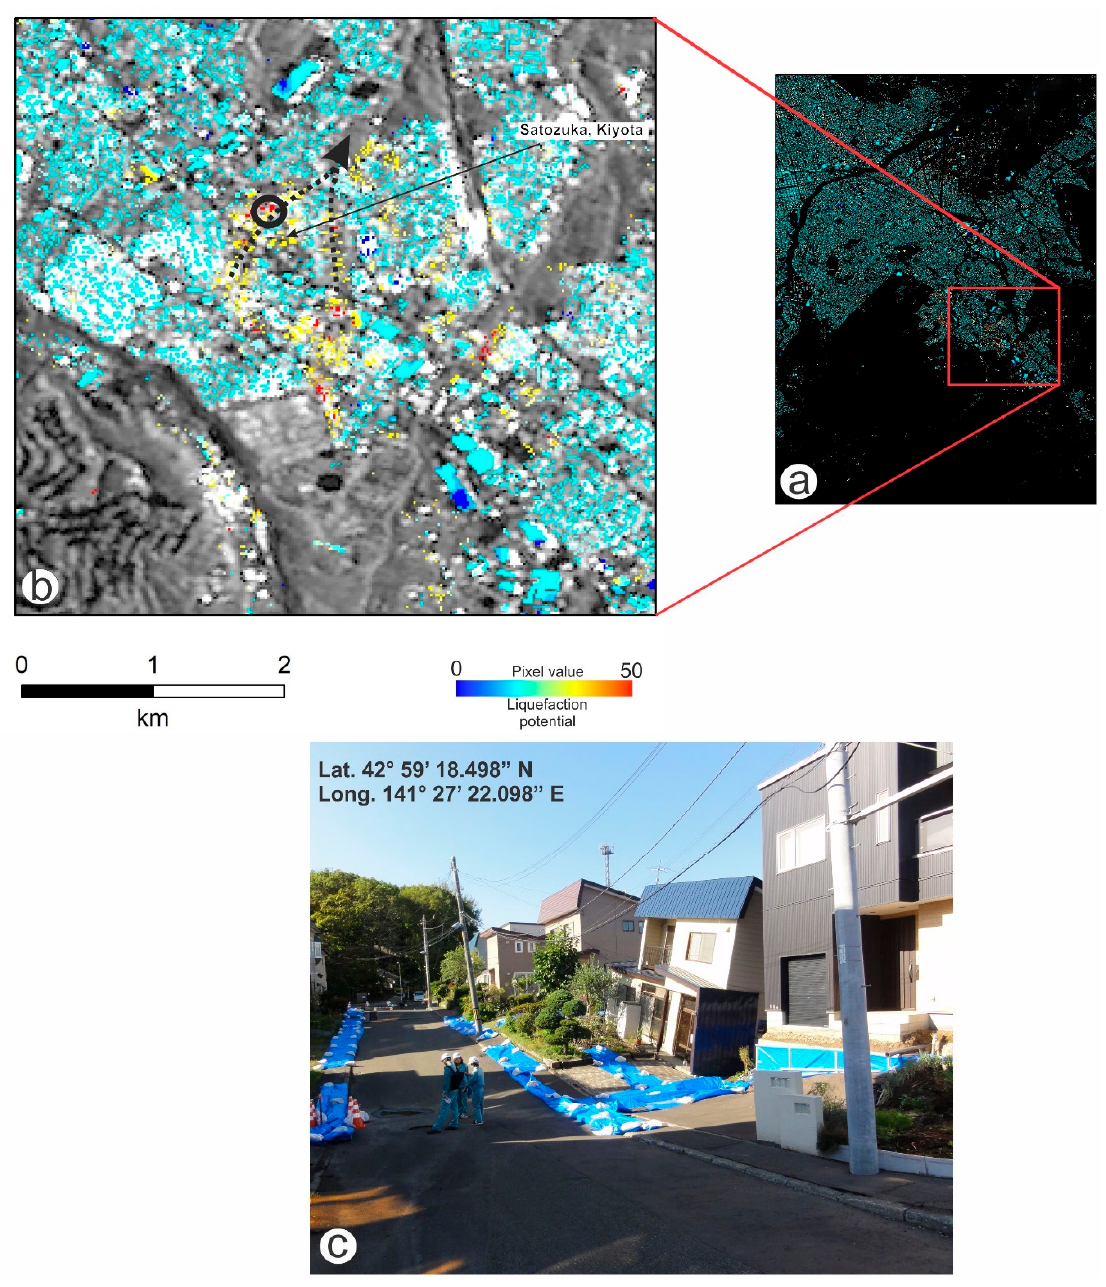
Figure 6. ( a ) WO map of Sapporo (track 116). ( b ) WO map of the Kiyota ward and Satozuka district overlain on the SAR intensity map (23 August 2018). Yellow-to-red pixels are mainly liquefaction-related damages, and the black circle is the location of the photograph in Figure 6c. Dashed lines show the traces of a valley in the Kiyota ward extracted from old maps prior to urban development. ( c ) Photograph of the Kiyota ward affected by liquefaction.